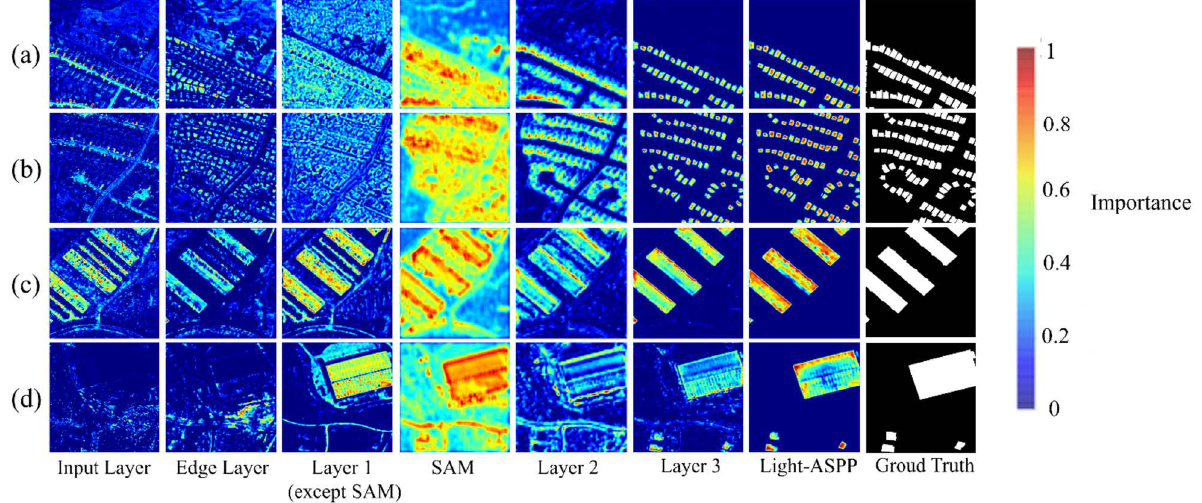
Figure 9. Shuffle-CDNet network visualization. The heatmaps are obtained with respect to the key modules of the Shuffle-CDNet. Red denotes higher importance to the prediction and blue denotes lower importance. ( a – d ) are four instances, respectively.